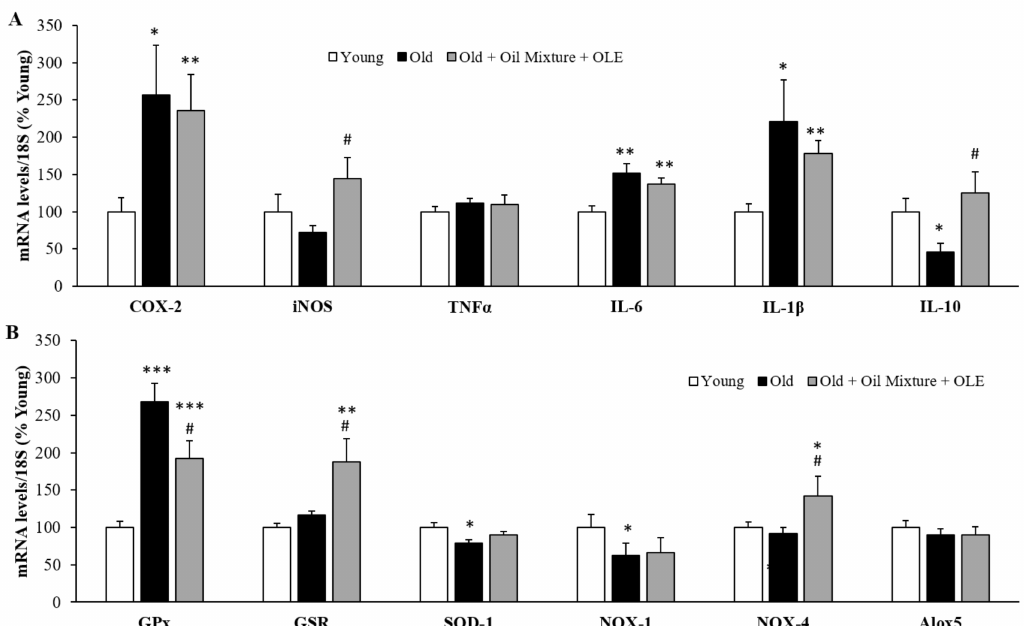
Figure 4. Gastrocnemius mRNA concentrations of cyclooxigenase-2, inducible Nitric Oxide Synthase, Tumor Necrosis Factor α and Interleukin 6, 1 β and 10 ( A ); and of Glutathione Peroxidase and Reductase, Super Oxide Dismutase 1, NADPH oxidases 1 and 4 and Lipoxygenase ( B ) of young rats, old rats and old rats treated 21 days with the Oil Mixture and the OLE. Values are represented as mean ± SEM. * p < 0.05 vs. Young; ** p < 0.01 vs. Young; *** p < 0.001 vs. Young; # p < 0.05 vs. Old.